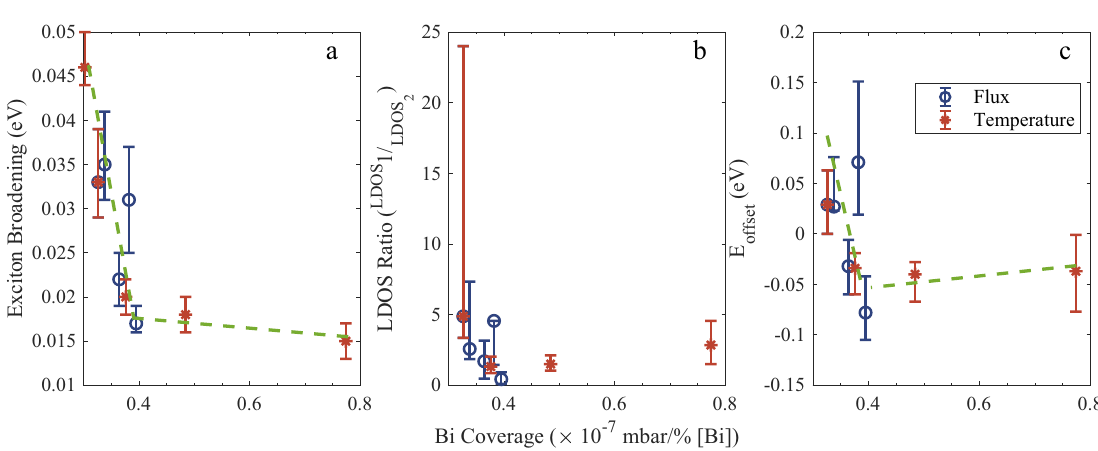
Figure 5. ( a ) σ G , ( b ) LDOS ratio and ( c ) E offset plotted against Bi coverage calculated from bismuth content and BEP. Green dashed lines have been added to guide the